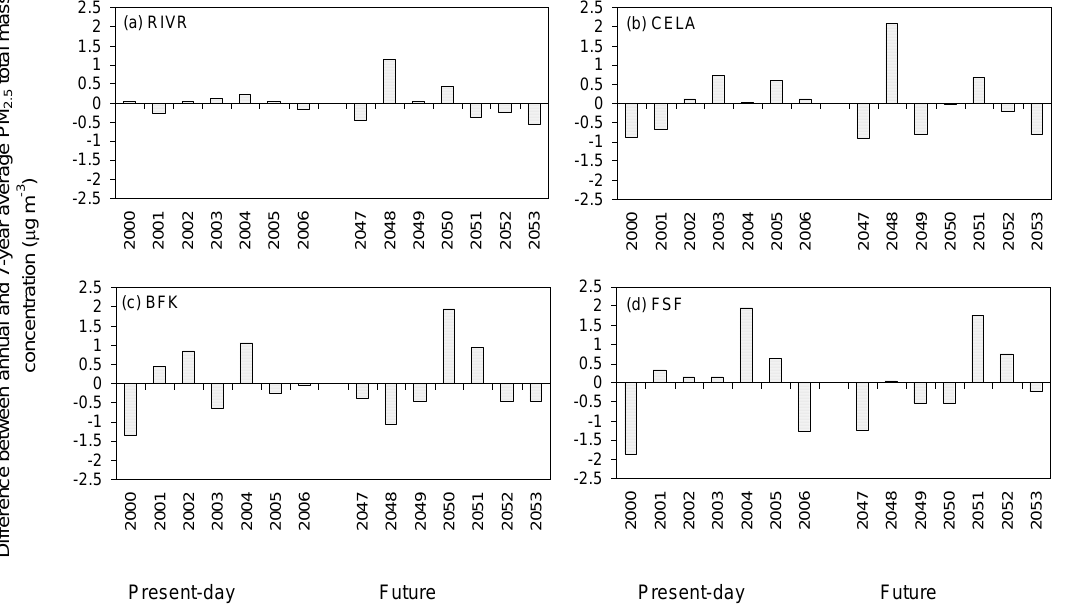
Fig. 5. Predicted variations around the 7-year average PM 2 . 5 total mass concentration at four sites in California: (a) Riverside-Rubidoux Fig. 5: Predicted variations around the 7-year average PM total mass concentration at 2.5 (RIVR), (b) Central Los Angeles (CELA), (c) Bakersfield (BFK), and (d) Fresno four sites in California: (a) Riverside-Rubidoux (RIVR), (b) Central Los Angeles (CELA), (c) Bakersfield (BFK), and (d) Fresno (FSF)